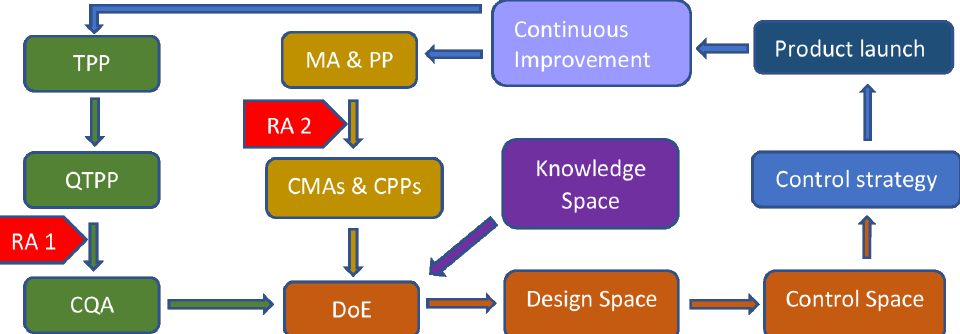
Figure 2. Life-cycle in the development of the pharmaceutical product by QbD implementation. From the target product profile (TPP), quality TPP (QTPP) is chosen and then risk assessment 1 (RA 1) is applied to analyze, which QTPP can be critical quality attributes (CQAs). RA 1 is nothing but just the analysis to select a particular QTPP as CQA. RA 2 refers to failure mode and